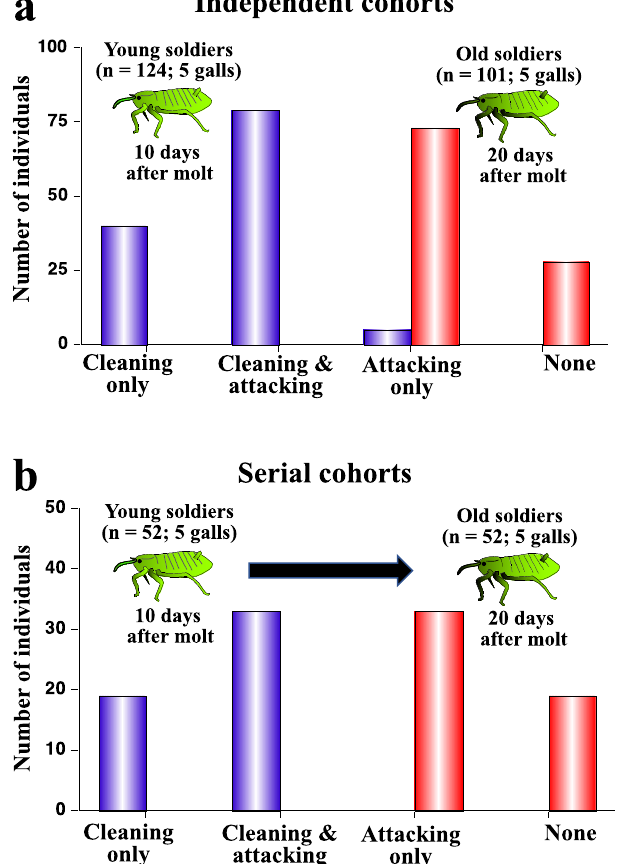
Figure 3. Social behaviors performed by young soldiers and old soldiers of T. styaci reared on artificial diet plates. ( a ) Observations of independent cohorts, in which 124 young soldiers (10 days after second instar molt) from 5 galls and 101 old soldiers (20 days after second instar molt) from 5 galls were independently collected and subjected to behavioral observations. Difference in frequencies of social behaviors between young soldiers and old soldiers was statistically significant (Chi-square test; P < 0.0001). ( b ) Observations of serial cohorts, in which 52 young soldiers (10 days after second instar molt) from 5 galls were collected and subjected to behavioral observations, and 10 days later, the same 52 soldiers (20 days after second instar molt) were subjected to behavioral observations again. Difference in frequencies of social behaviors between young soldiers and old soldiers was statistically significant (Chi-square test; P <